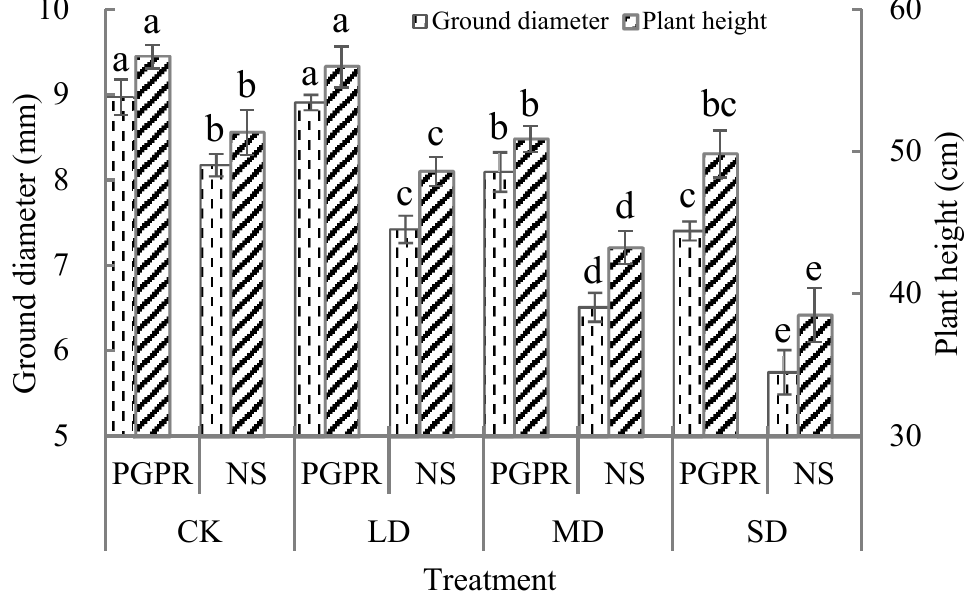
Figure 2. Effect of different drought and inoculation treatments on the ground diameter and plant height of walnut seedlings. Bars are means, and error bars are standard deviations (n = 6). CK: normal watering; LD: light drought stress; MD: medium drought stress; SD: severe drought stress. Different letters indicate significant differences among treatments at p < 0.05 by LSD.